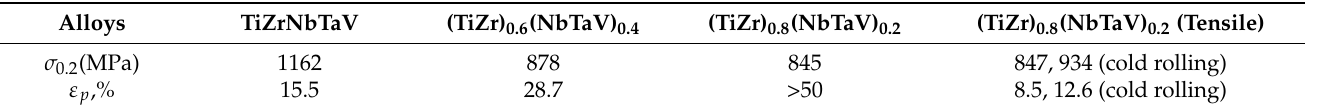
Table 2. The engineering yield stress and strain data for both compressive and tensile data of (TiZr) x (NbTaV) 1 − x HEAs.